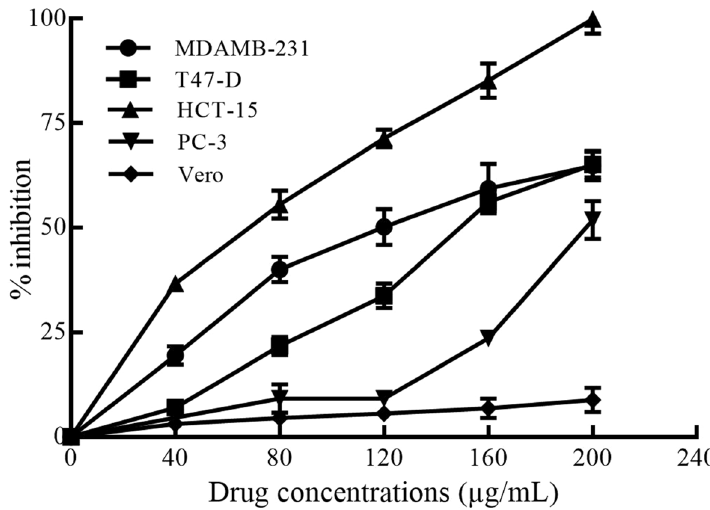
Fig. 2 Cytotoxicity of K. pinnatum on different cancer cell lines by MTT